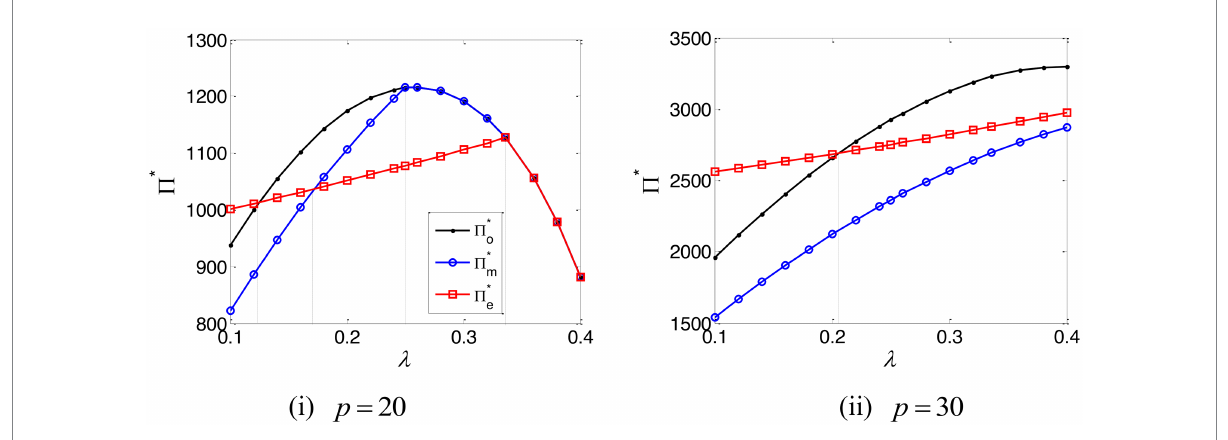
FIGURE 8 The total profit of the entire supply